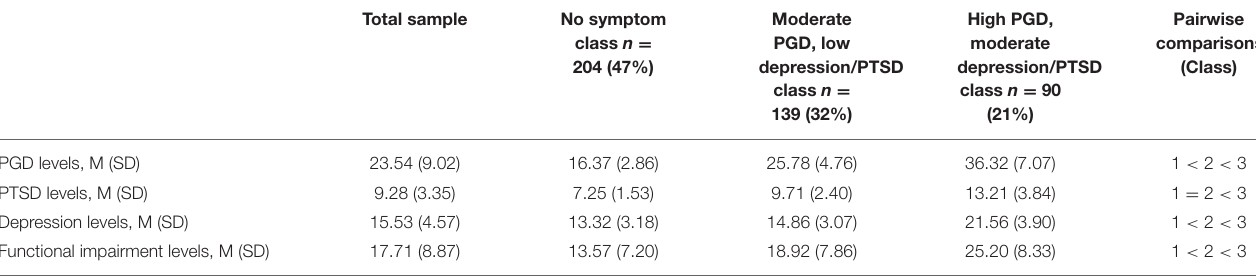
TABLE 3 | Univariate associations between PGD, PTSD, depression, and functional impairment levels and classes ( N =